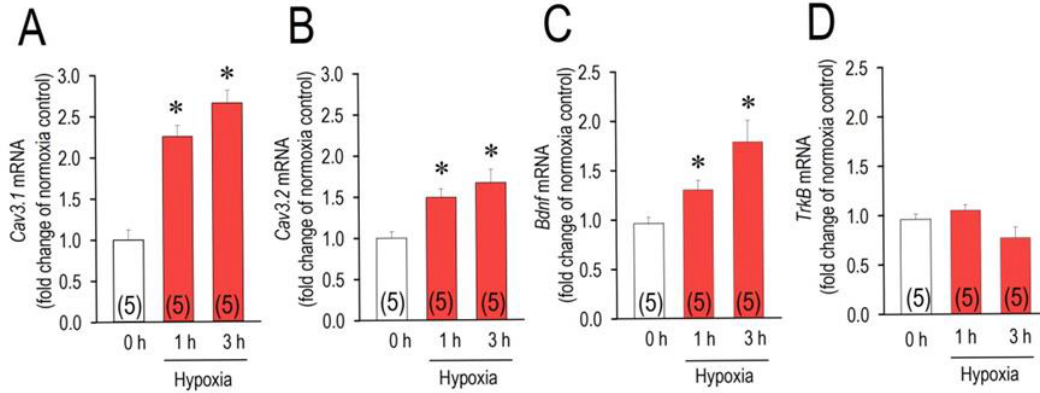
Figure 1. Changes of the levels of Cav3.1 -, Cav3.2 -, Bdnf -, and TrkB -mRNA expression in cardiomyocytes exposed to hypoxia. Rat neonatal cardiomyocytes were cultured in the normoxic conditions (21% O 2 ) for 3 h or hypoxic conditions (1% O 2 ) for 1 h or 3 h. Expression of each mRNA ( A – D ) was assessed by real-time PCR. Amount of each mRNA was normalized to those in normoxia (0 h) as assigned as 1.0. Data were expressed as mean ± SE. (n = 5). * p < 0.05, compared with those in the normoxic control group (3 h). Numbers of experiments are given in parentheses.